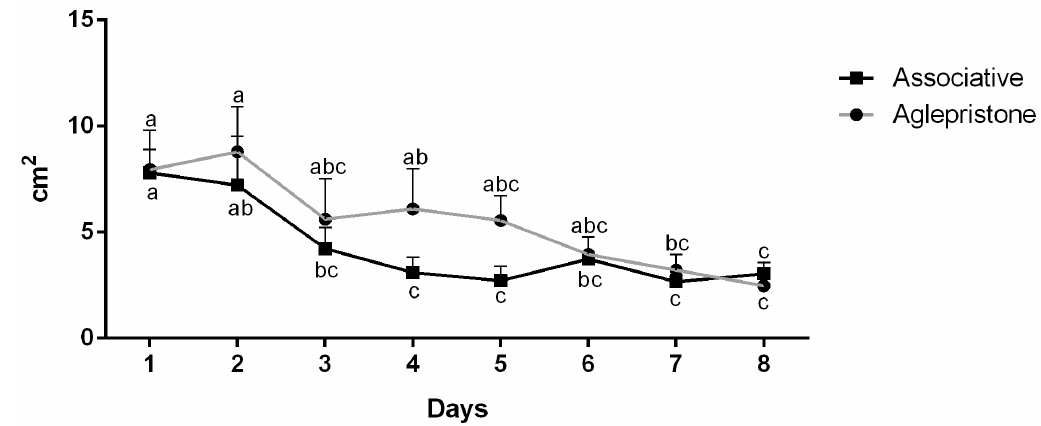
Figure 1. Uterine area (cm²) throughout the experimental period (1–8 days) in the Associative and Aglepristone groups. a–c values with different letters differ significantly with